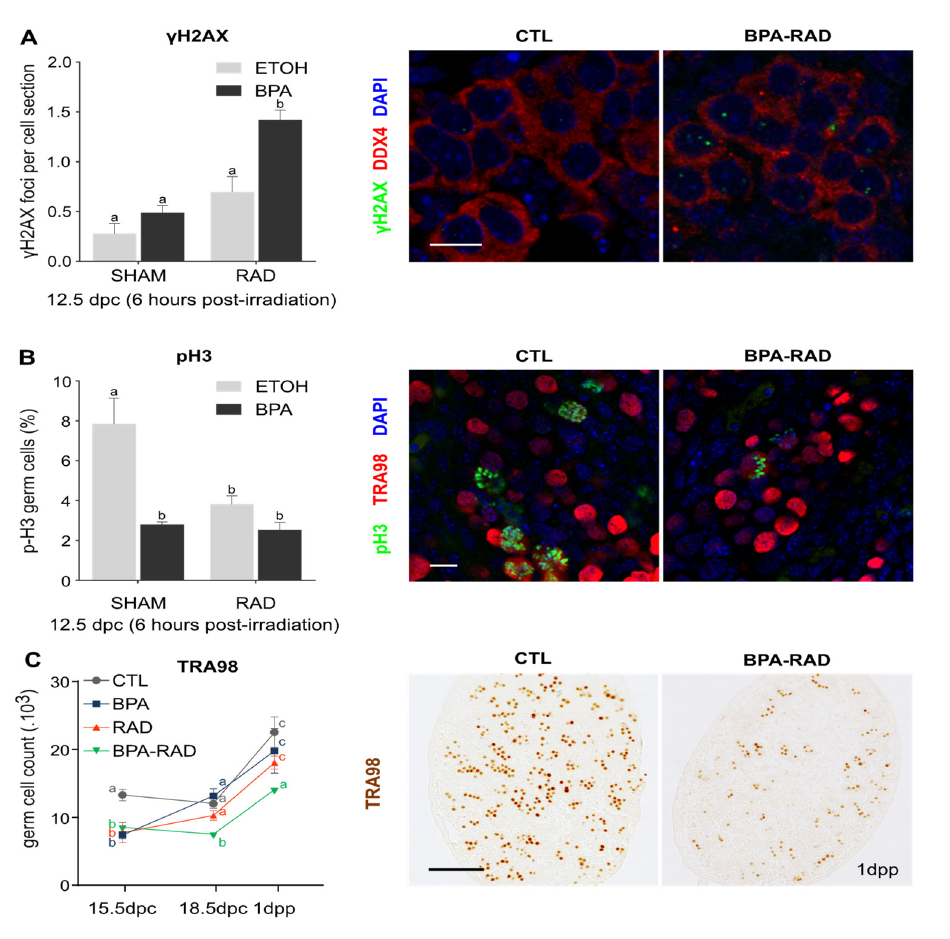
Figure 1. Additive effects of bisphenol A (BPA) and ionizing radiation (RAD) on fetal germ cells. Testes from 12.5 days post coïtum (dpc) embryos exposed to BPA (10 µ M) were collected 6 h after irradiation (0.2 Gy), and ( A ) the number of γ -H2AX foci per germ cell (DDX4-positive cells) and ( B ) the percentage of pH3 positive germ cells (TRA98-positive cells) were quantified after immunofluorescence staining. Each bar represents the mean ± sem from 5 independent samples. At least 100 nuclei were counted per sample. Means with different letters are significantly different ( p < 0.05; two-way ANOVA followed by a Tukey test). Right panels show representative pictures of the staining in control (CTL) and co-exposed (BPA-RAD) gonads. Bars represent 10 µ m. ( C ) Gonads from fetal (15.5 and 18.5 dpc) and postnatal (1 day postpartum) mice exposed to BPA and/or RAD were collected, and the number of germ cells per gonad was quantified after immunostaining for TRA98 (left panel). Each point represents the mean ± sem. n = 5–7 gonads from independent samples and 3 independent exposures. Means with different letters are significantly different (two-way ANOVA followed by a Tukey test). Right panels show representative pictures of the staining (TRA98 in brown) in 1 dpp control (CTL) and co-exposed (BPA-RAD) testes. Bars represent 100 µ